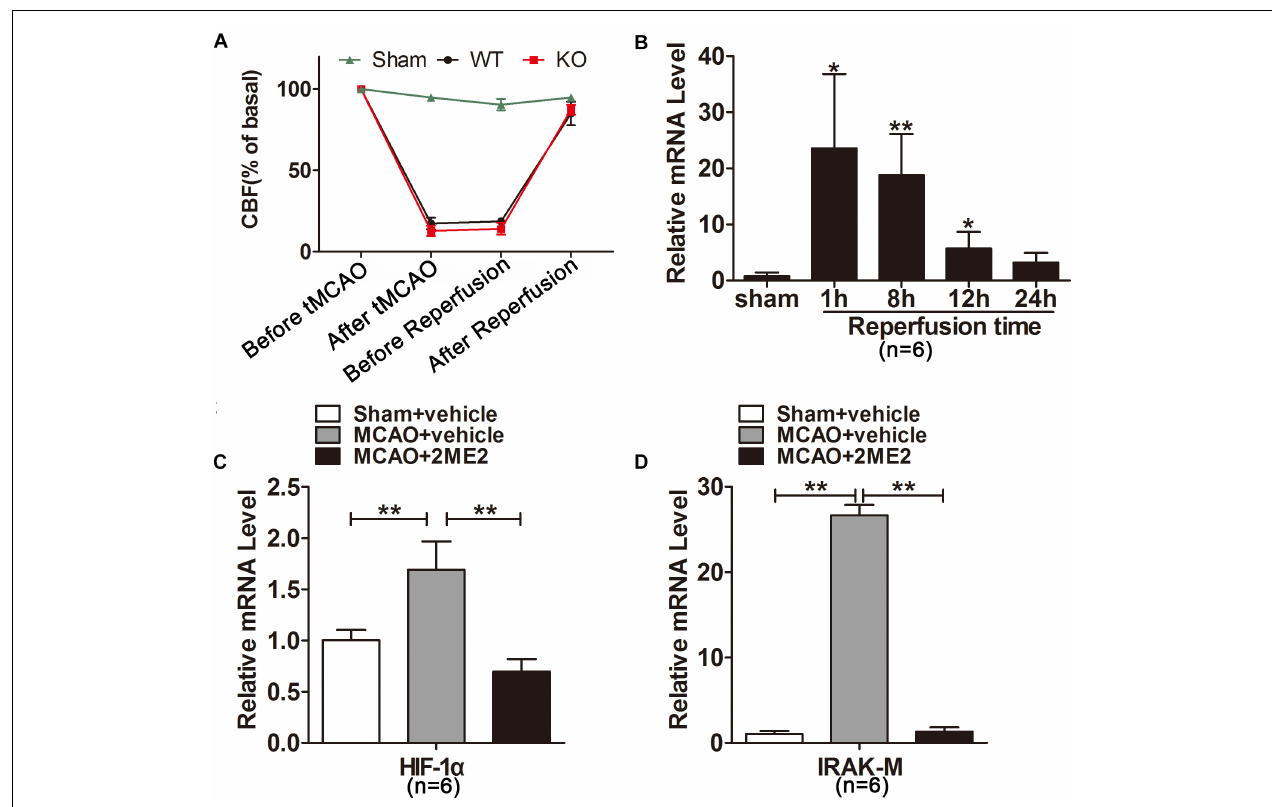
FIGURE 1 | Interleukin-1 receptor-associated kinase (IRAK)-M was significantly increased after cerebral ischemia reperfusion. (A) Cerebral blood flow (CBF) of each mouse subjected to tMCAO detected by laser-Doppler and showed as percentage of basal level. (B) Relative mRNA levels of IRAK-M were measured by real-time RT-PCR at different time points after reperfusion in the infarcted cerebral hemisphere. Marked upregulation was noted after 1 and 8 h of reperfusion. (C , D) Effect of 2ME2 on the mRNA expression of HIF-1 α (C) and IRAK-M (D) in the ipsilateral hemisphere at 1 h after reperfusion. Data are presented as mean ± SD, n = 6 per group. ∗ P < 0.05, ∗∗ P < 0.01 vs. sham